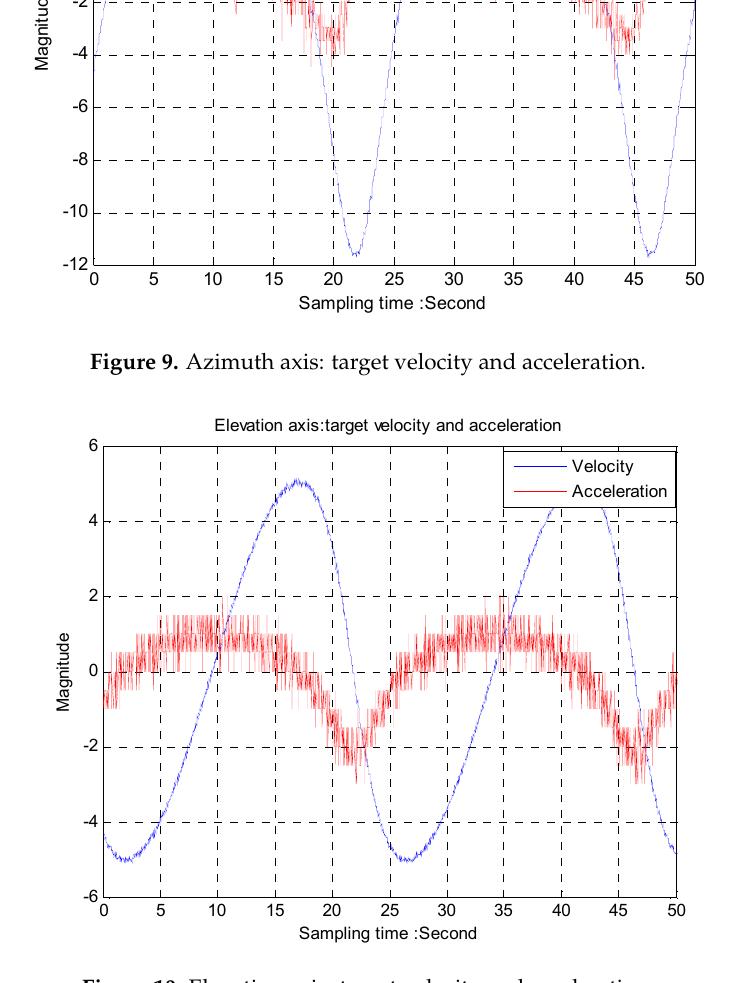
Figure 11. The LOS error with feed forward control.